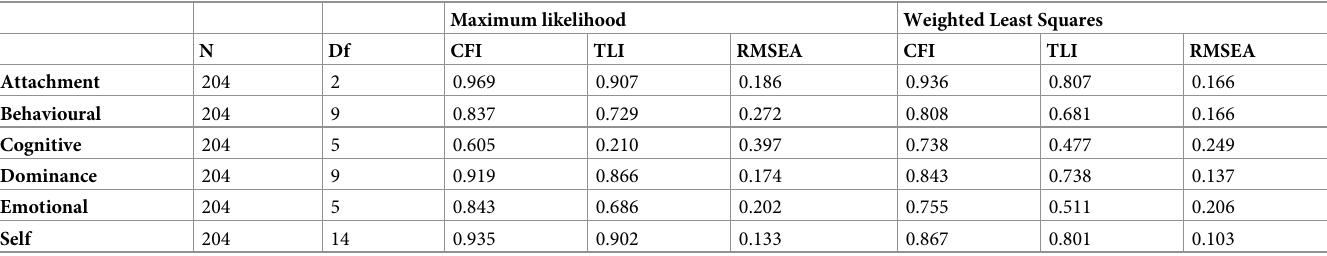
Table 7. Confirmatory factor analysis of CAPP dimensions with all items.